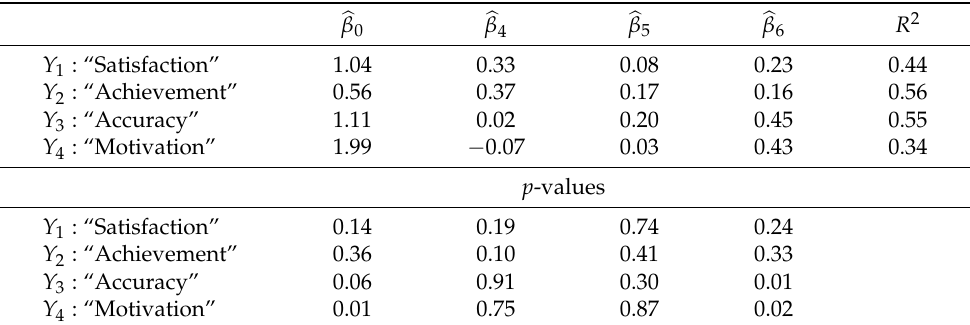
Table 2. Estimated parameters, corresponding p -values, and coefficient of determination R 2 in the regression of performance measures ( Y 1 , . . . , Y 4 ) on selected key training method variables ( X 4 , X 5 , X 6 ) for employees in the banking sector.